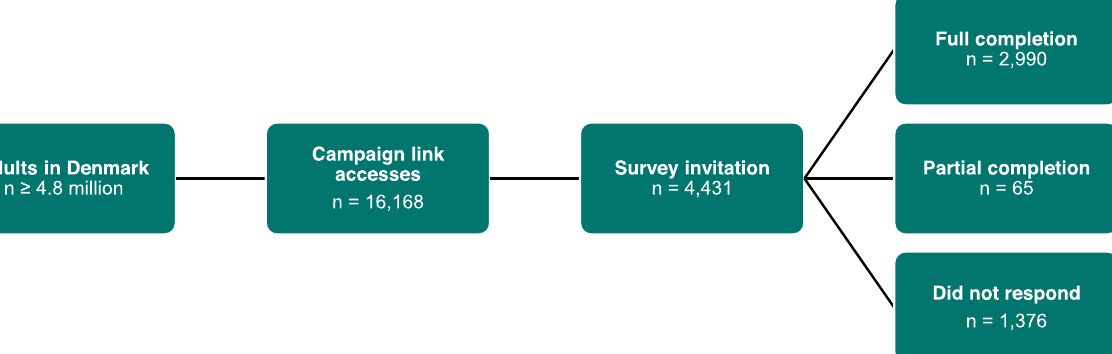
Fig. 1 Participant flow diagram. The campaign link was accessed 16,168 times with 4,708 acceptances of the invitation to participate. After exclusion of duplicates, the number of participants included in the HINDER panel was 4,431, of whom 2,990 completed all questions of the Healthcare Utilization